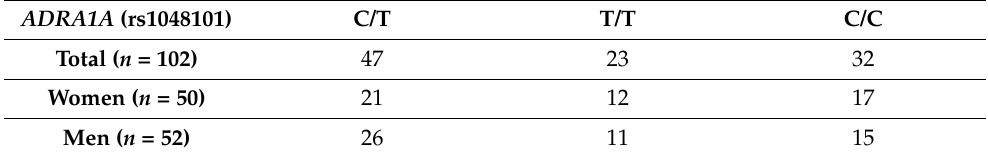
Table 4. The genotype distribution of ADRA1A p.Arg347Cys (rs1048101) in the study population. ADRA1A